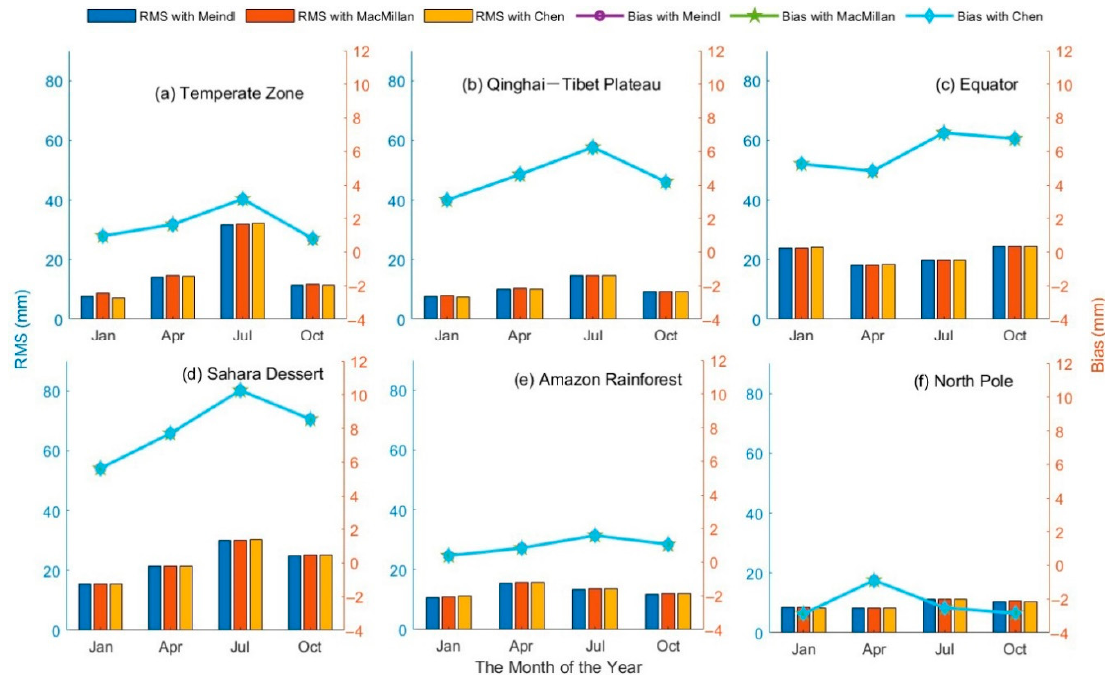
Figure 6. The RMSs and biases for the six regions in the four seasons: ( a ) Temperate Zone ( b ) Qinghai—Tibet Plateau ( c ) Equator ( d ) Sahara Dessert ( e ) Amazon Rainforest ( f ) North Pole.